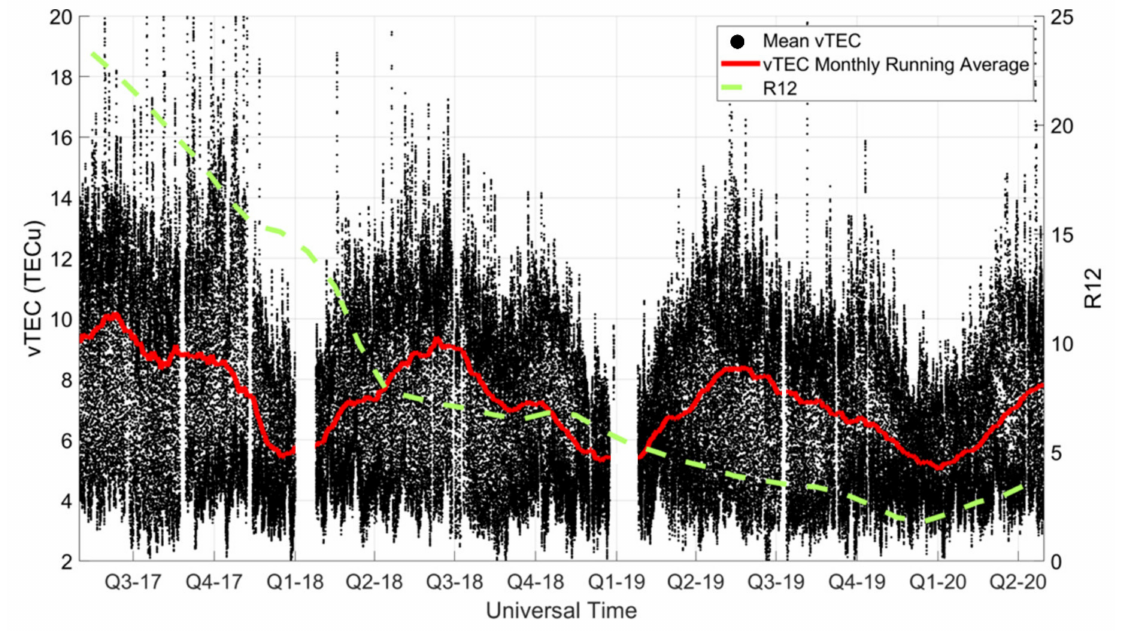
Figure 8. Seasonal variation of mean TEC by considering the period 1 May 2017 to 30 April 2020. Red line represents the TEC monthly running average. Green curve is the 12-months smoothed relative sunspot number